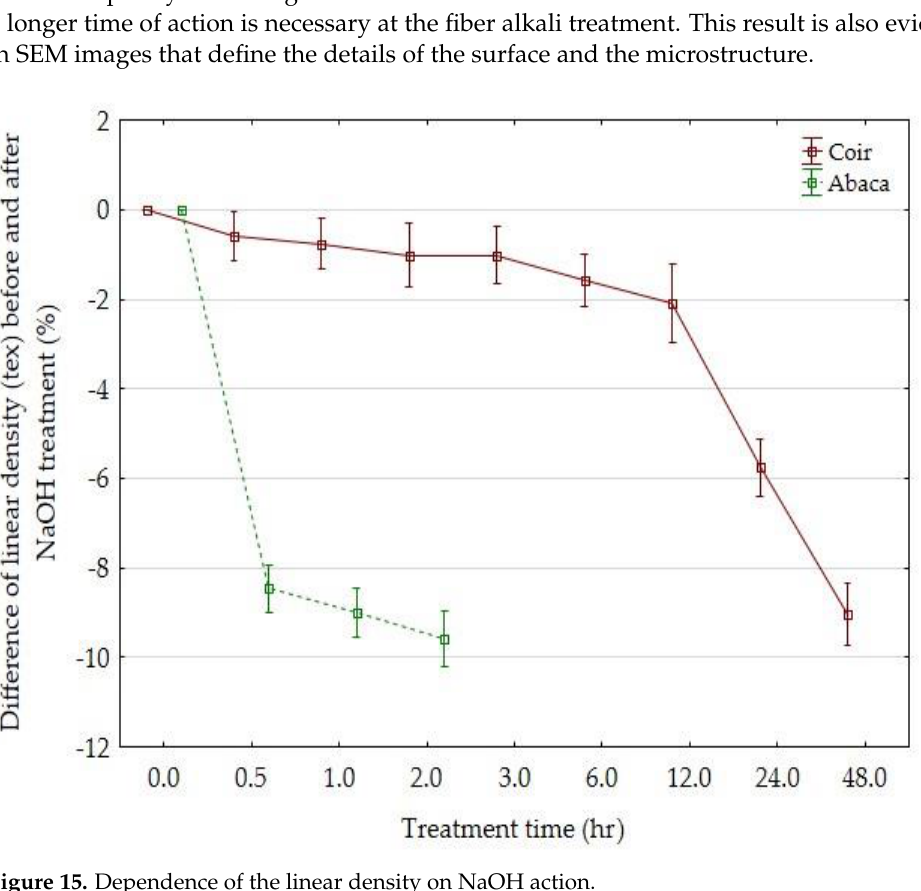
Figure 15. Dependence of the linear density on NaOH action.